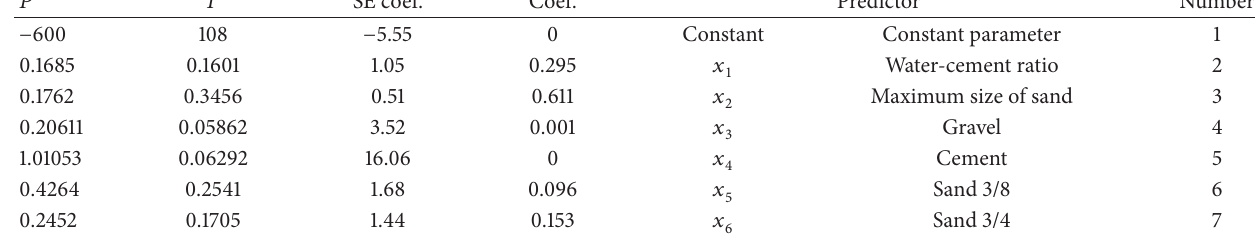
Table 5: Coefficients of MLR model.